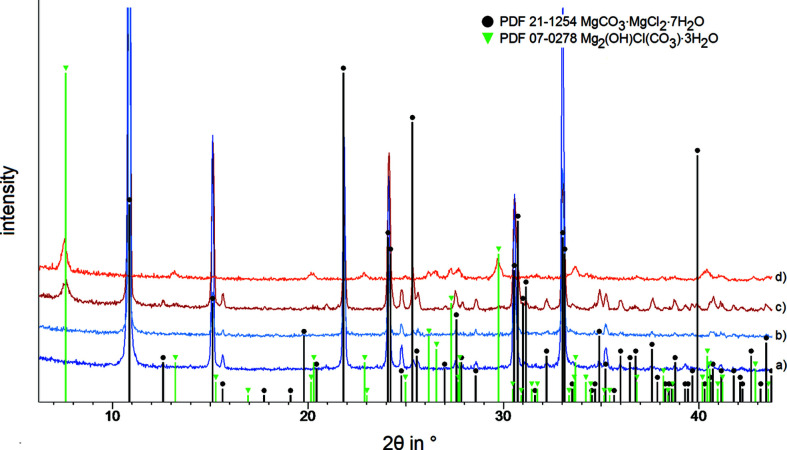
Powder XRD patterns of MgCO3·MgCl2·7H2O under ambient conditions (Cu Kα1 radiation) for (a) the unwashed product immediately after the synthesis, (b) the unwashed product stored in the air after 19 months, (c) the product washed with ethanol after storage in the air for 10 d and (d) the product washed with ethanol after storage in the air for 19 months. Reference data: MgCO3·MgCl2·7H2O (PDF 21-1254) and Mg2(OH)Cl(CO3)·3H2O (PDF 07-0278).